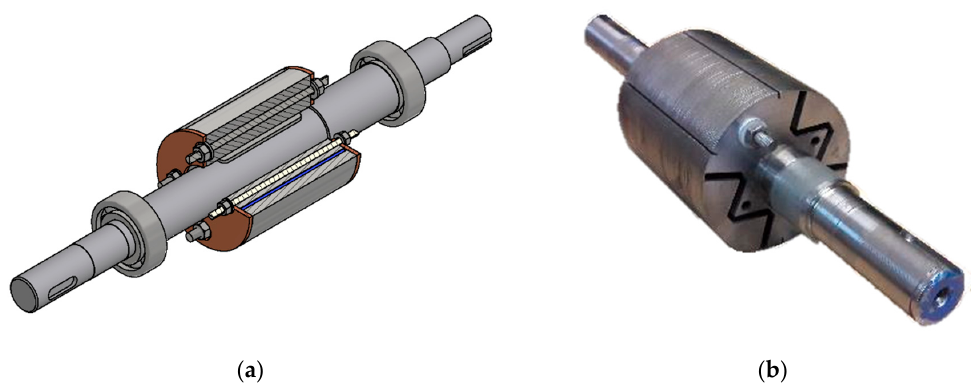
Figure 5. Isometric view of: ( a ) the designed rotor and ( b ) the built rotor without magnets.